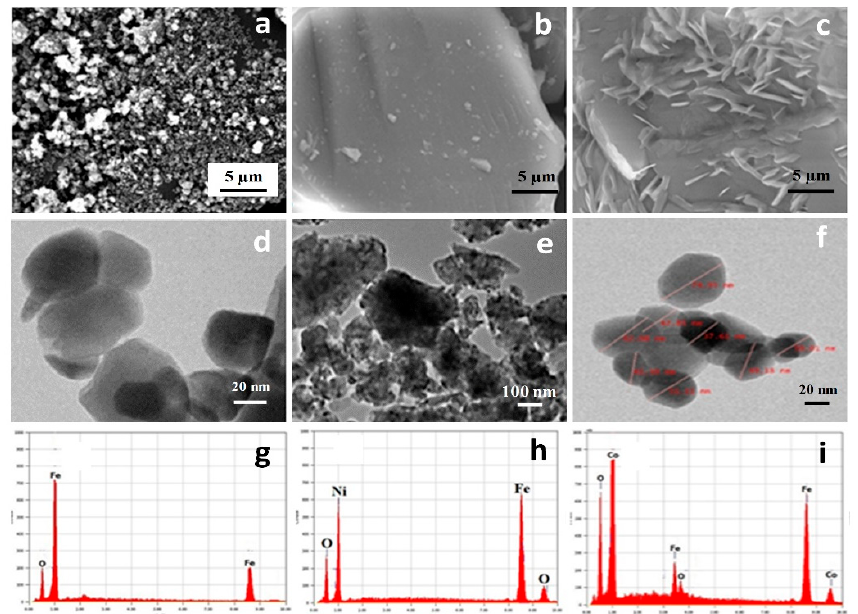
Figure 1. SEM images of ( a ) Fe 3 O 4 ( b ) NiFe 2 O 4 , ( c ) CoFe 2 O 4 NPs; TEM images of ( d ) Fe 3 O 4 . ( e ) NiFe 2 O 4 , ( f ) CoFe 2 O4 NPs; EDS image of ( g ) Fe 3 O 4 , ( h ) NiFe 2 O 4 , ( i ) CoFe 2 O 4 NPs.